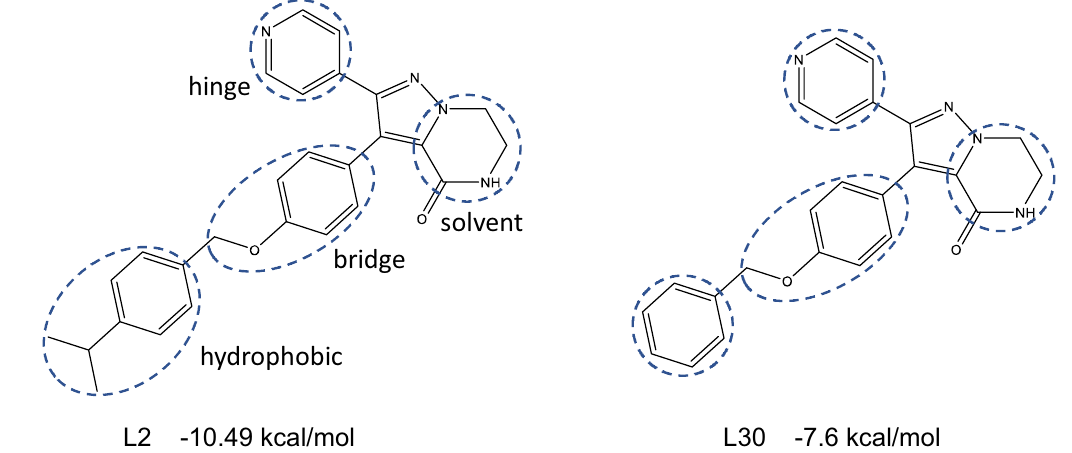
Figure 1. Compounds L2 and L30, with which other compounds are paired for the TIES simulations. The cycles show where the modifications are made. The four positions, at which variations are made, are labelled as: hinge (hg) which interacts with the hinge of the kinase, hydrophobic (hy) which binds in a hydrophobic pocket, solvent (s) which points toward the bulk solvent, and bridge (b) which sits in the middle of the